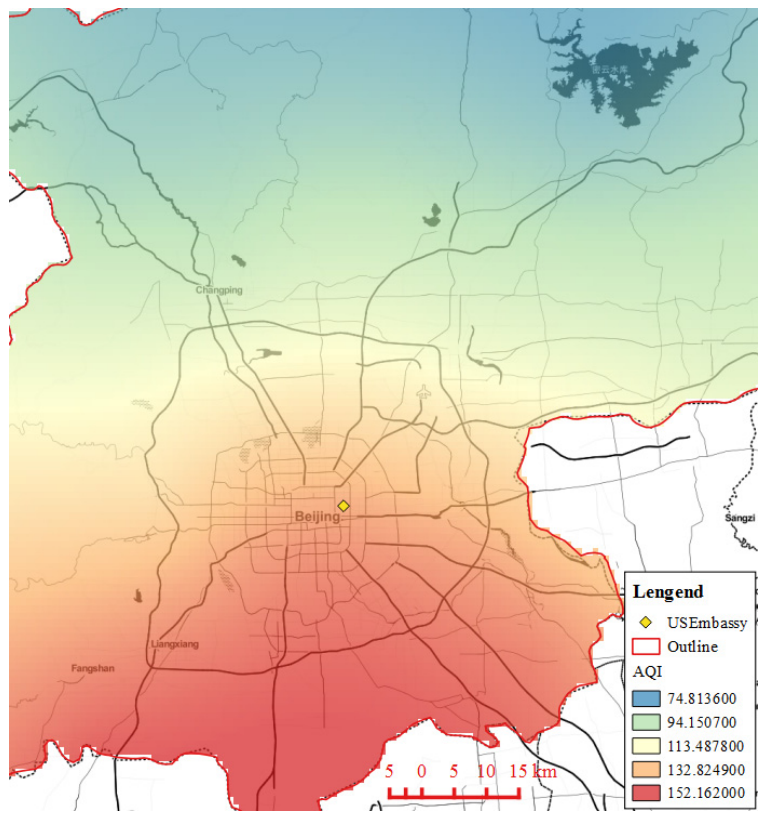
Figure 11. Average AQI Heatmap of PM 2.5 from November 2013 to February 2014 in Beijing.